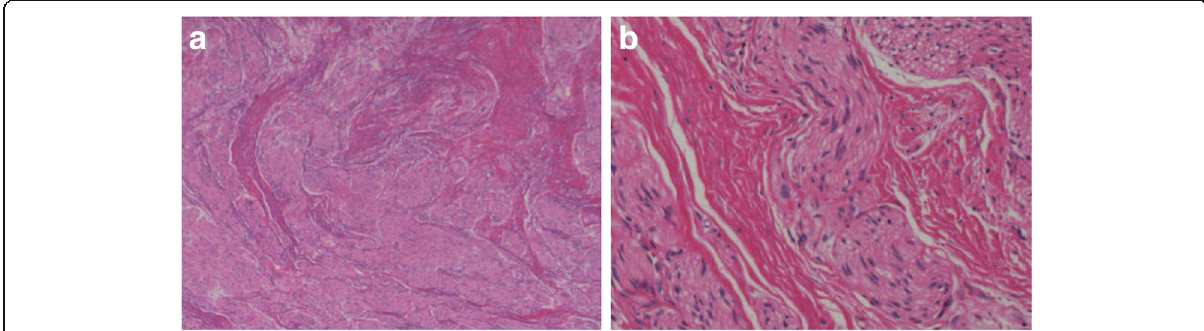
Fig. 4 Histopathological findings. Thick nerve fibers without atypia proliferated with a bundle-like or spiral pattern. Hematoxylin – eosin staining. a × 20 and b ×